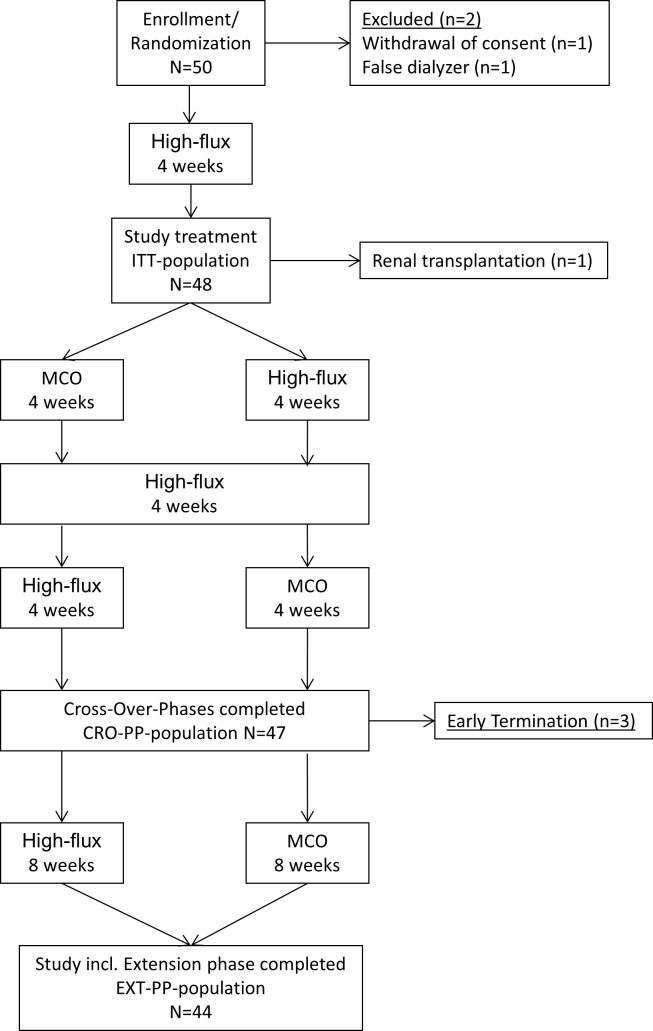
Patient Flow Chart.